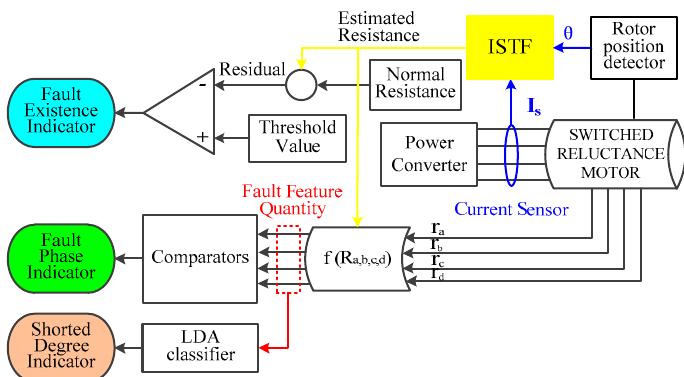
Figure 3. The schematic of the proposed detection method. STF: strong track filter; LDA: linear discriminant analysis.